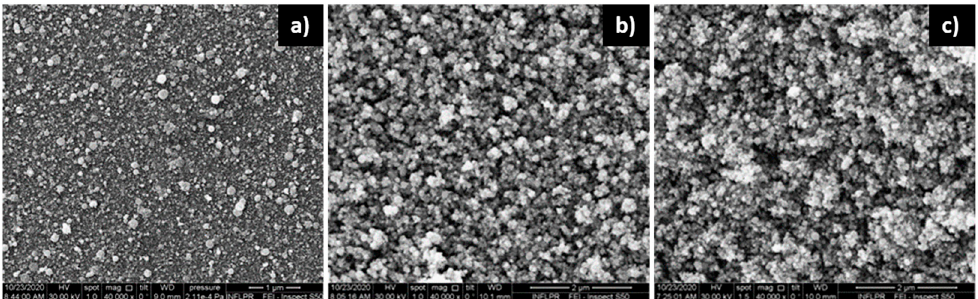
Figure 8. Pd films deposited at 10 kHz with a ps laser with 0.3 W and 532 nm, in ( a ) 2’23”; ( b ) 30’; ( c ) 2 h. The deposition pressure was 400 mTorr Ar.